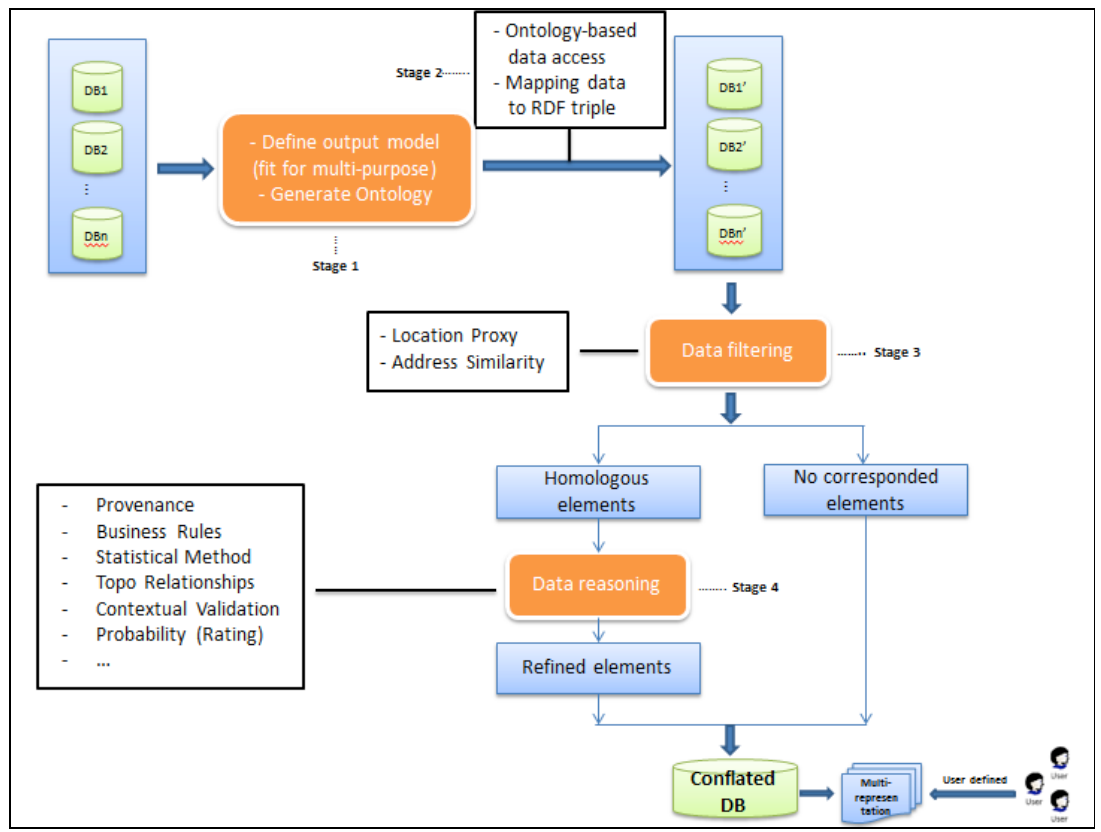
Figure 1. Data Conflation Conceptual